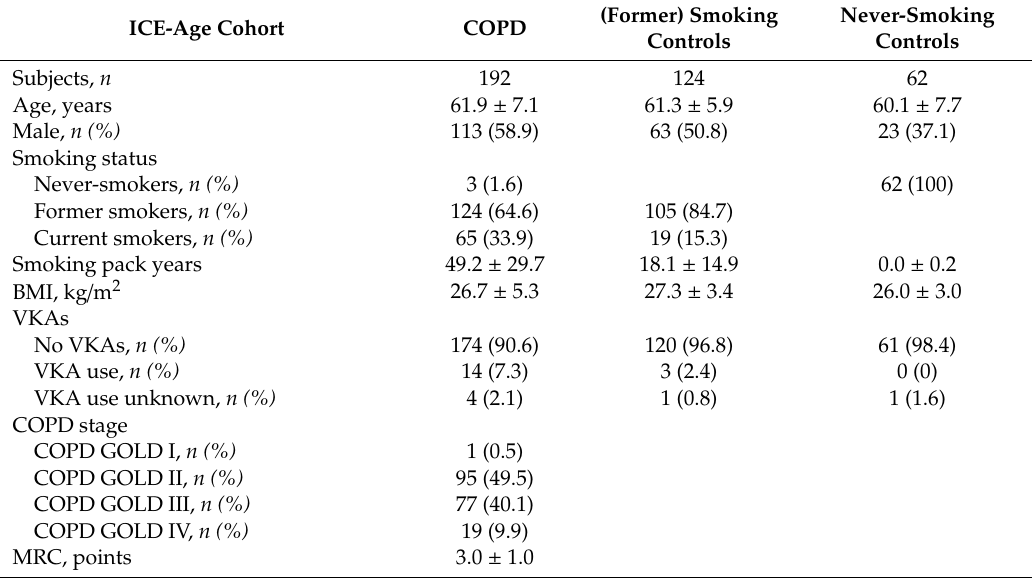
Table 1. Patient characteristics of the Individualized COPD Evaluation in relation to Ageing (ICE-Age) cohort. Continuous data are presented as mean ± standard